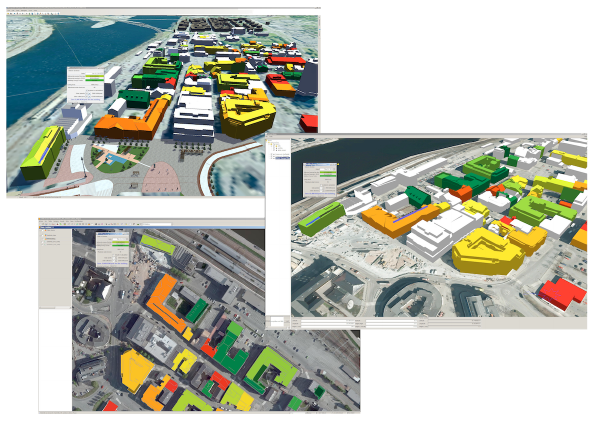
Figure 2. Identical GMO's displayed in three different